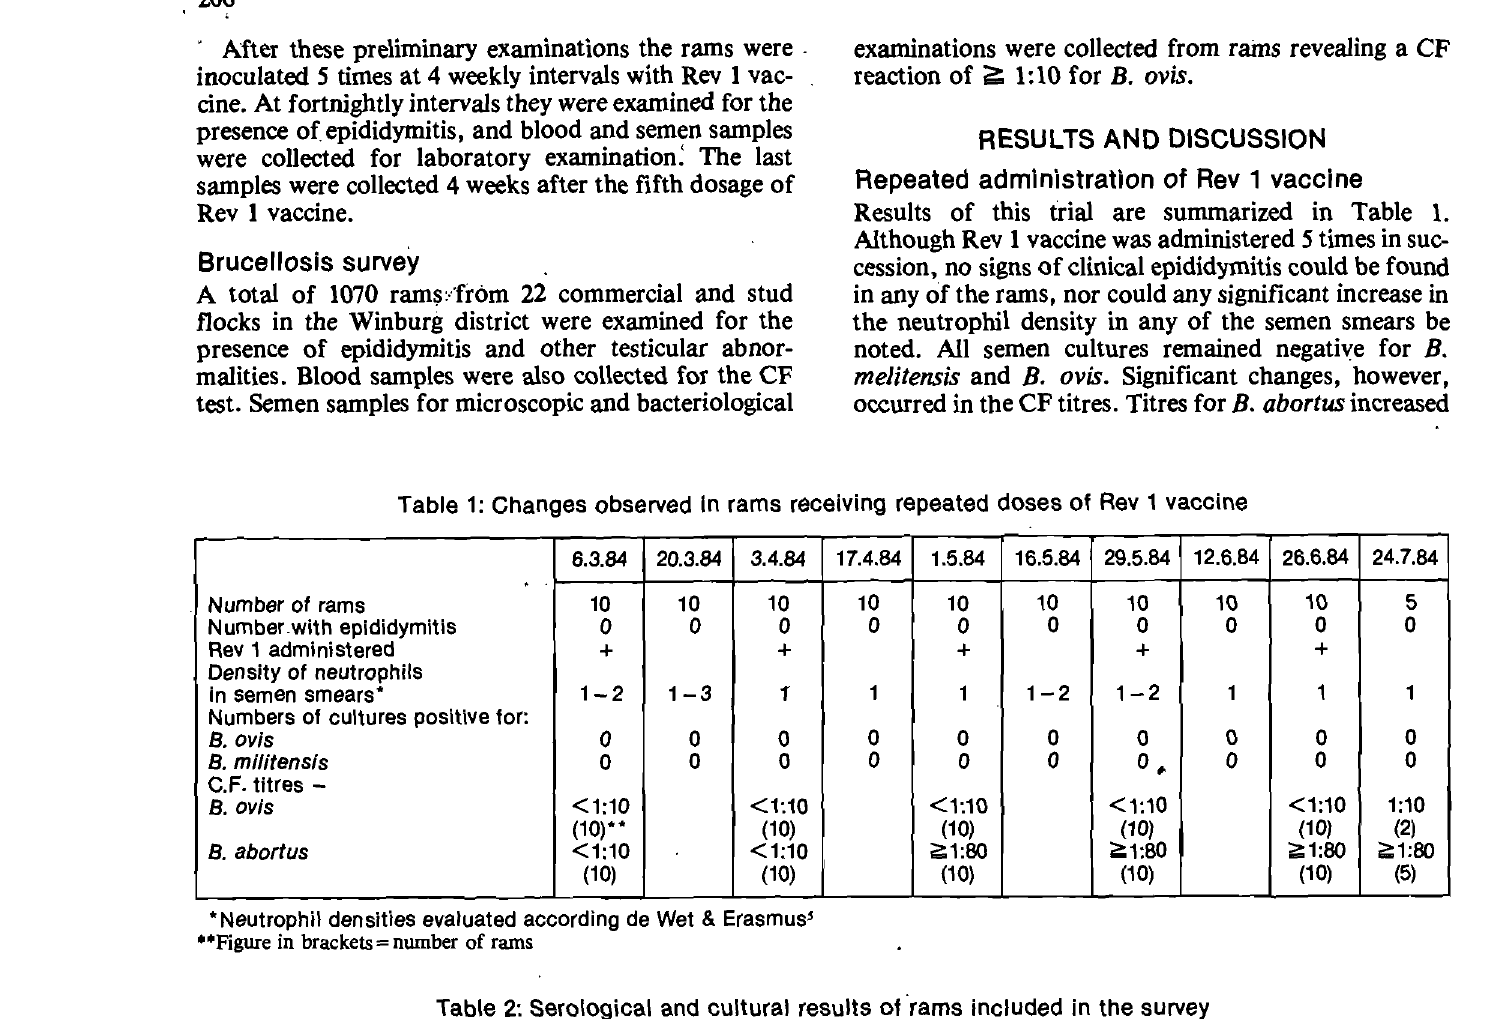
Table 2: Serological and cultural results of "rams included in the survey Farm no. Type of